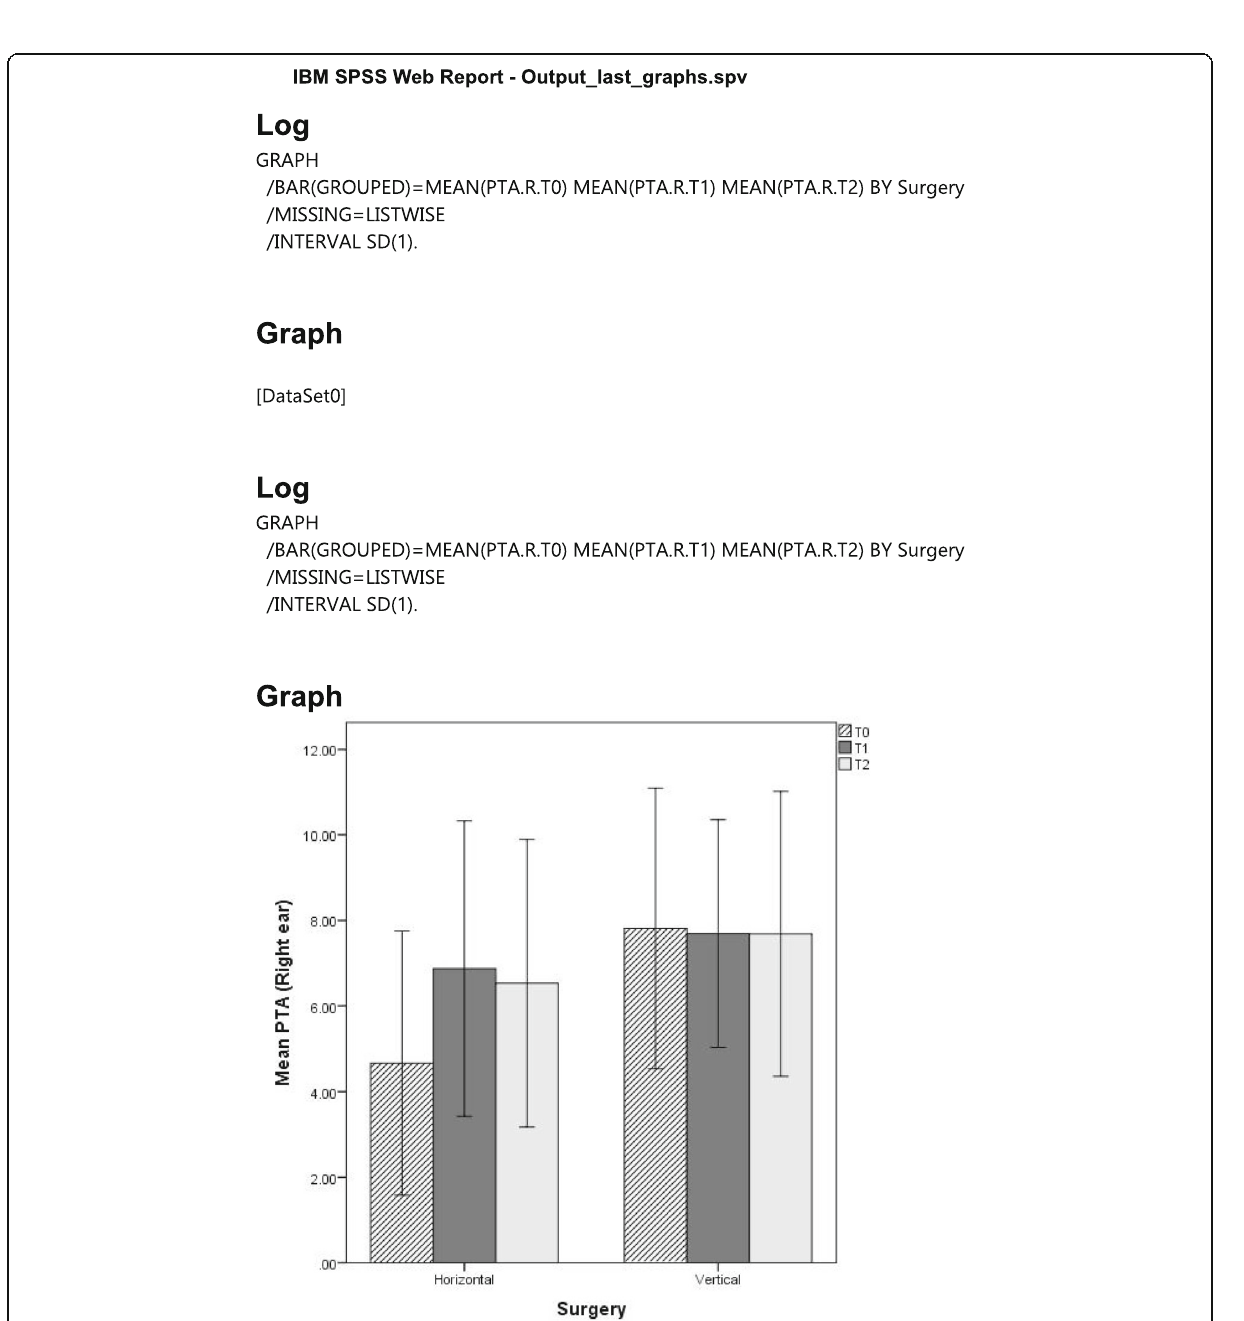
Fig. 1 Mean PTA over time according to the type of movements (horizontal or vertical) in the right